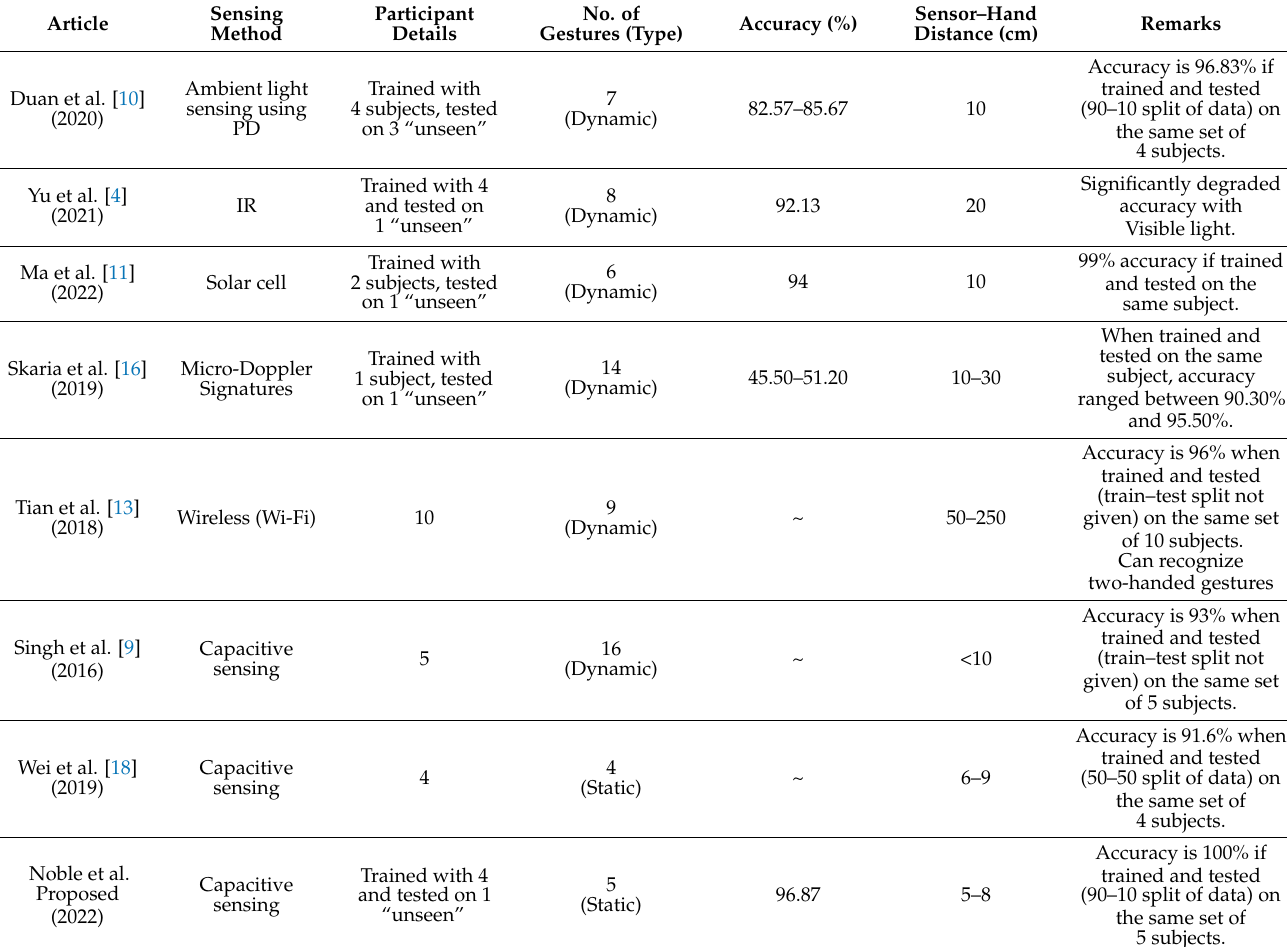
Table 1. The proposed system benchmarked against a collection of recent works on hand gesture recognition. It is one of the few systems that is capable of accurately identifying static hand